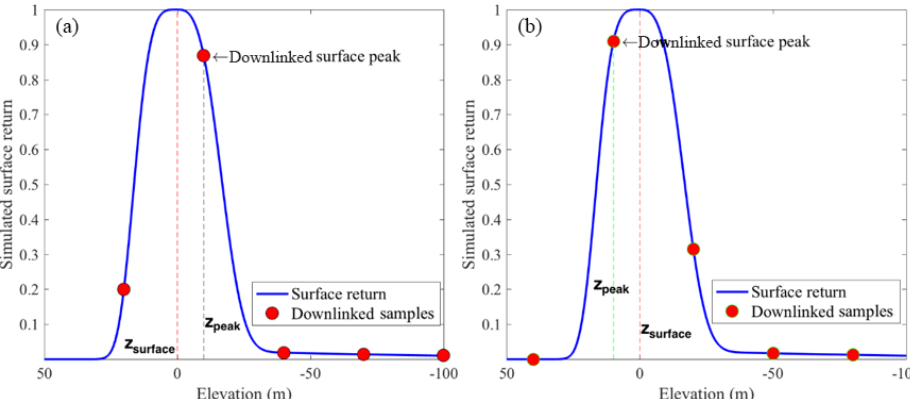
Figure 2. The simulated surface return pulse after low-pass filter (blue curve) and CALIOP downlinked 30m resolution samples (red circles). The surface elevation ( z surface ) is assumed to be 0m (red dashed line). The elevation below the surface is set to negative value. The black and green dash lines are altitudes where the downlinked surface sample reaches its peak value ( z peak